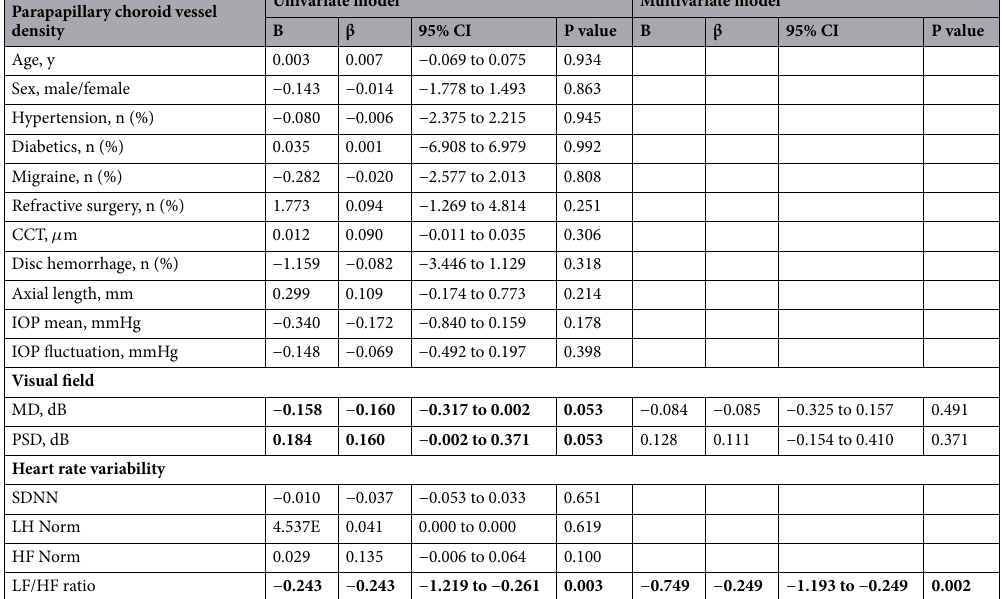
Univariate model Multivariate